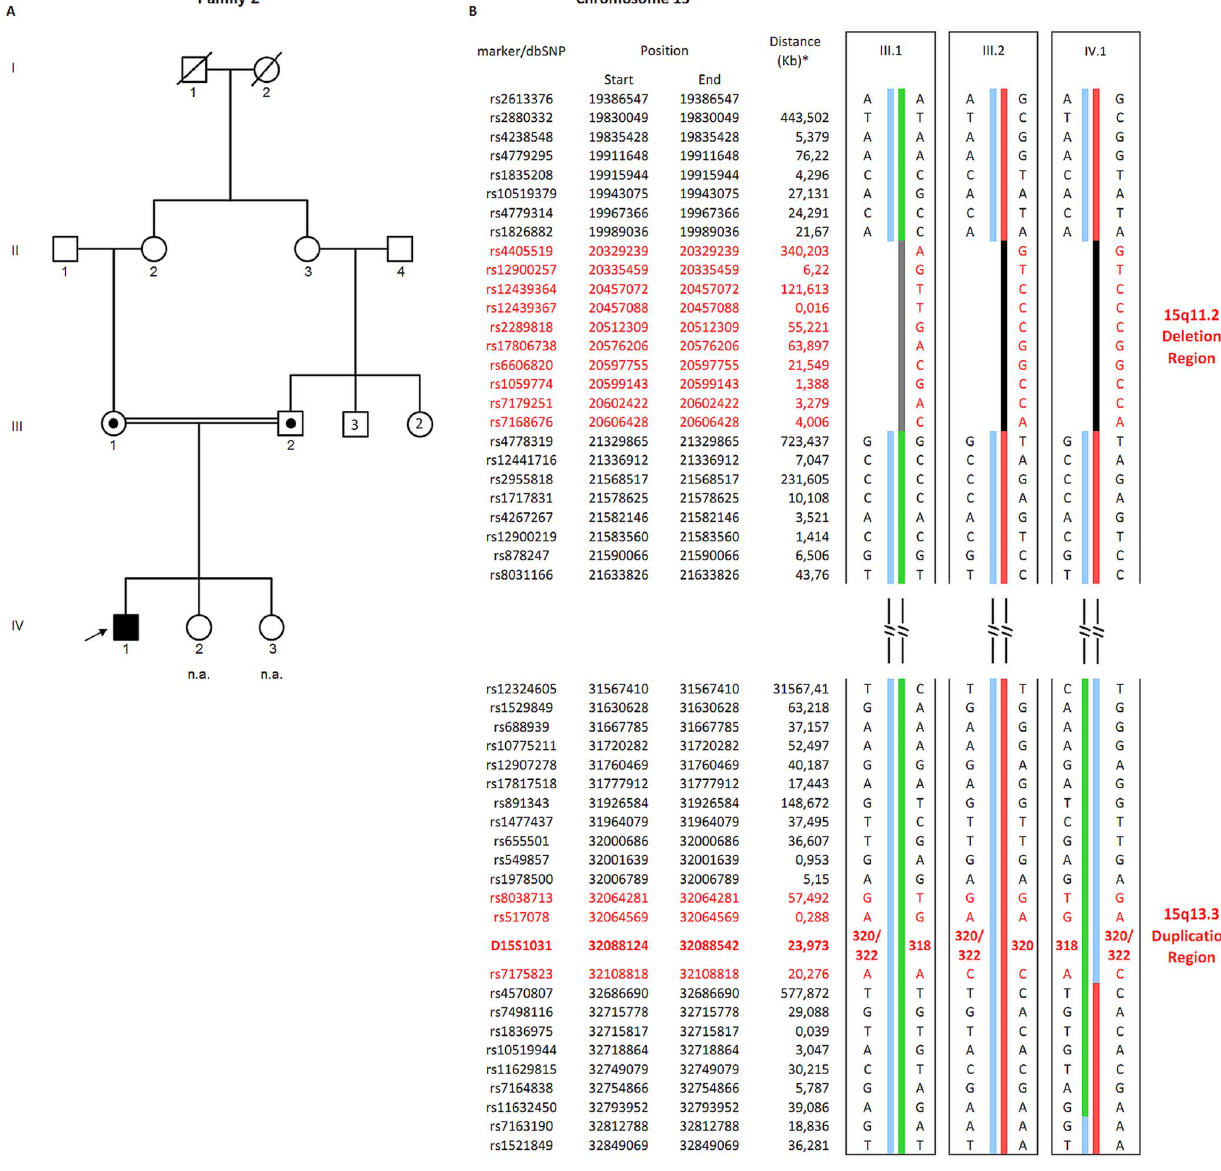
Figure 1. ASD-affected individual 2 pedigree and haplotypes. A) Pedigree of the ASD-affected individual. B) Haplotype analysis of SNPs and microsatellite markers at 15q11-q13. ASD-affected individual – filled symbol; Carriers of 15q13.3 duplication and 15q11.2 deletion – symbols with a black dot in the middle; individuals unavailable or not affected – empty symbols; non-available individuals – n.a. * Distance (in kilobases) from anterior to posterior marker/dbSNP. The other microsatellite markers are not showed.